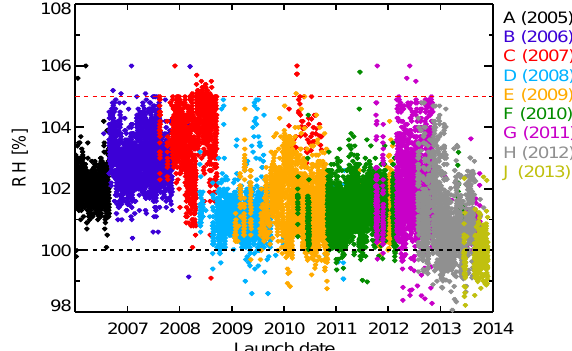
Figure 12. Time series of reading of the RS92 humidity sensor Fig. 12. Time-series of reading of the RS92 humidity sensor when inserted in the SHC (100% relative humid- when inserted in the SHC (100% relative humidity) prior to launch, ity) prior to launch, as part of the additional manufacturer-independent ground check. The colors depict the as part of the additional manufacturer-independent ground check. radiosonde’s production-year. The black dashed line represents the 100% level, whereas the red dashed line The colours depict the radiosonde’s production year. The black indicates 105%, the rejection criterion for humidity readings in the SHC. dashed line represents the 100% level, whereas the red dashed line indicates 105%, the rejection criterion for humidity readings in the